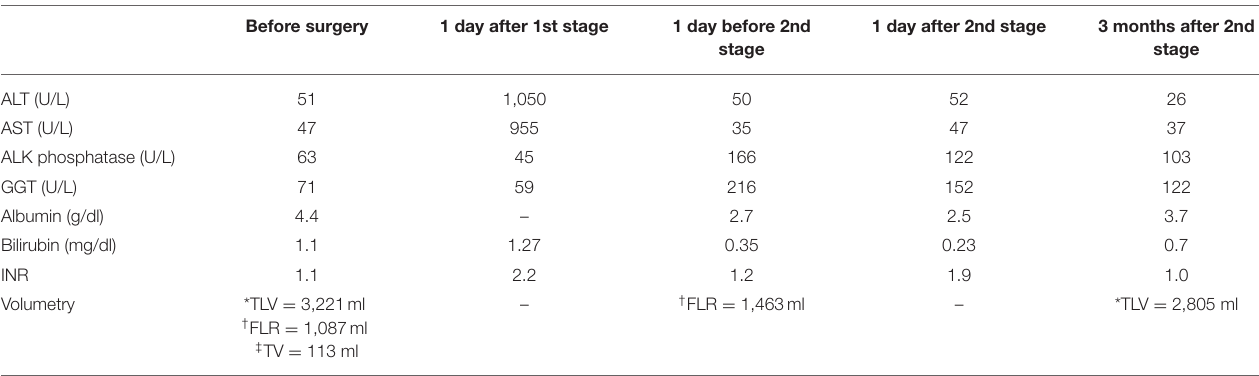
TABLE 1 | Pre- and postoperative follow-up